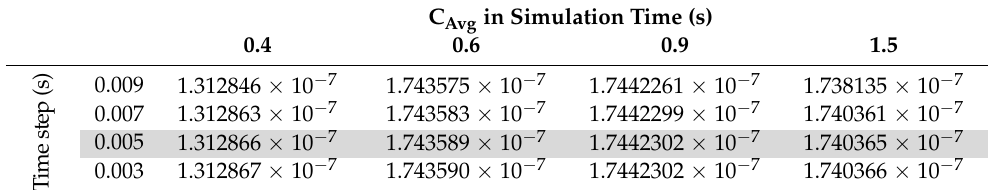
Table 4. Time-step independence study of C Avg .